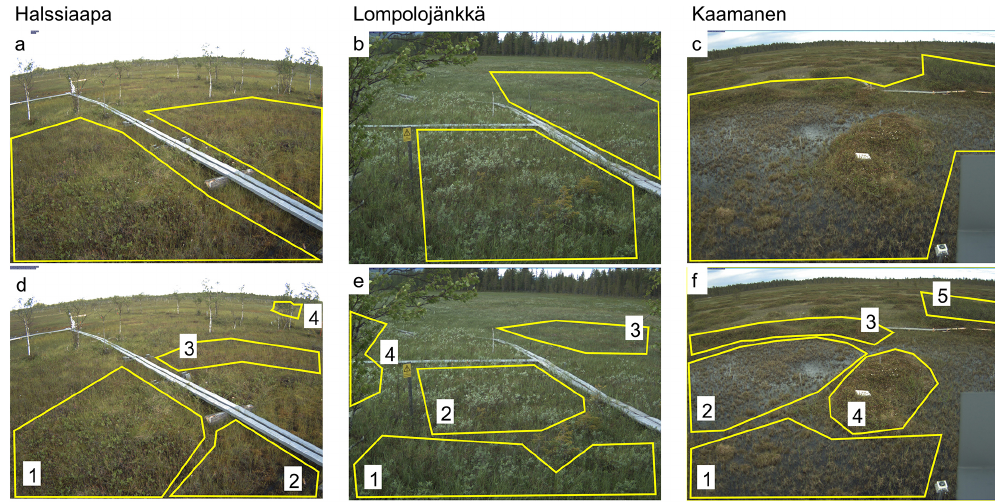
Figure 1. The regions of interest (ROIs) representing the overall vegetation at the site (a–c) and specific plant communities within the camera target areas (d–f) . The numbers 1–5 indicate the plant communities detailed in Table 1. Table 1. The dominant plant species characterizing the different plant communities within regions of interest (ROIs) at each site (Fig. 1d–f). Halssiaapa Lompolojänkkä Kaamanen ROI1 Menyanthes trifoliata Salix sp., Carex spp. Carex spp. and brown mosses ROI2 Sedges (mostly Carex spp.) Salix sp., Carex spp. Carex spp. and brown mosses ROI3 Andromeda polifolia and other shrubs Carex spp. Empetrum nigrum, Rubus chamaemorus ROI4 Betula pubescens Betula nana Rhododendron tomentosum , Rubus chamaemorus ROI5 Betula